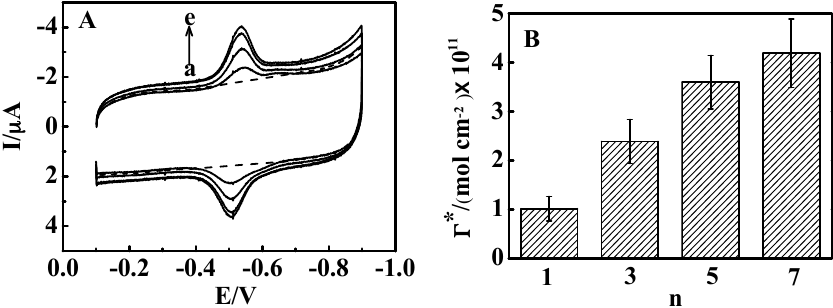
(Figure 2B), and final Γ * is about 4 times of the value of n = 1, indicating that the {Con A/GOD} n LbL films are successfully assembled on the PG/PDDA surface.